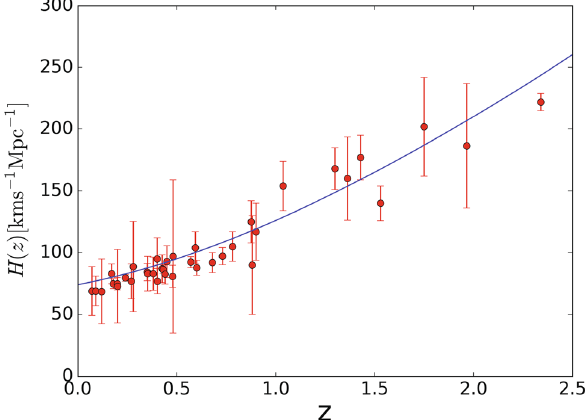
Fig. 9 38 OHD sets. The dots with error bars represent 38 available OHD sets so far. For the purpose of illustrating, we also plot H ( z ) value under Λ CDM, the blue